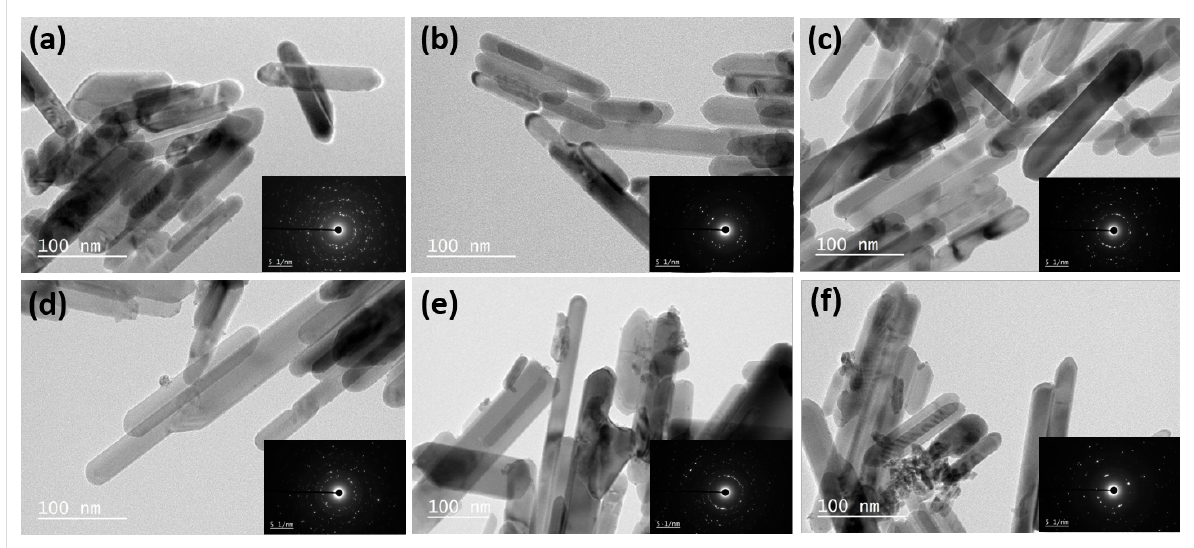
Figure 5: TEM images of (a) ZnO rods and (b–f) ZnO rods doped with 1, 3, 5, 7 and 10% Ce, respectively.